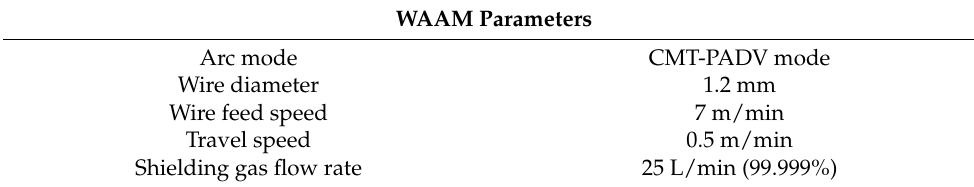
Table 2. Primary deposition parameters for wall-shaped structure of 2219 aluminum alloy.